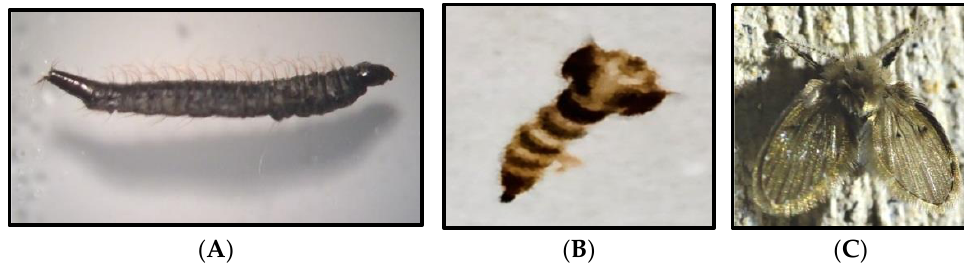
Figure 2. Full grown fourth stage larva ( A ) brought by our patient. Developmental pupa ( B ) and adult ( C ) of Clogmia albipunctata obtained by rearing in an incubator at 25 °C and 60% relative humidity.